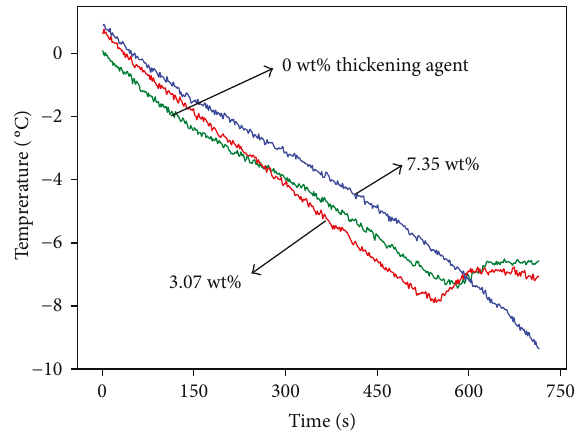
Figure 6: Step cooling curves of adding 0, 3.12, and 7.46wt% thickeners and 2.5wt% nucleating agent in the solution.